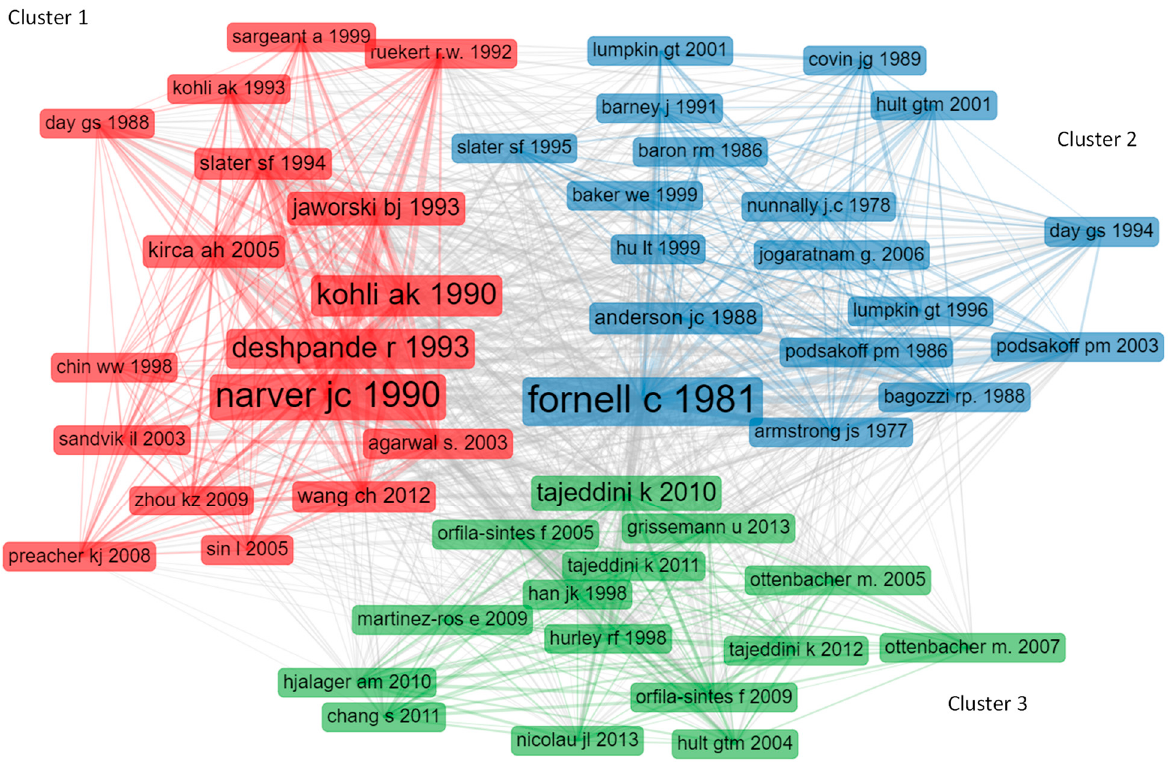
Figure 2. Co-citation network.